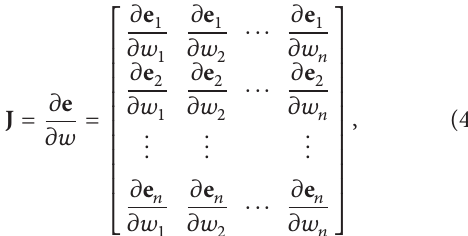
Table 4: Performance statistics of the ANN model during evalua-